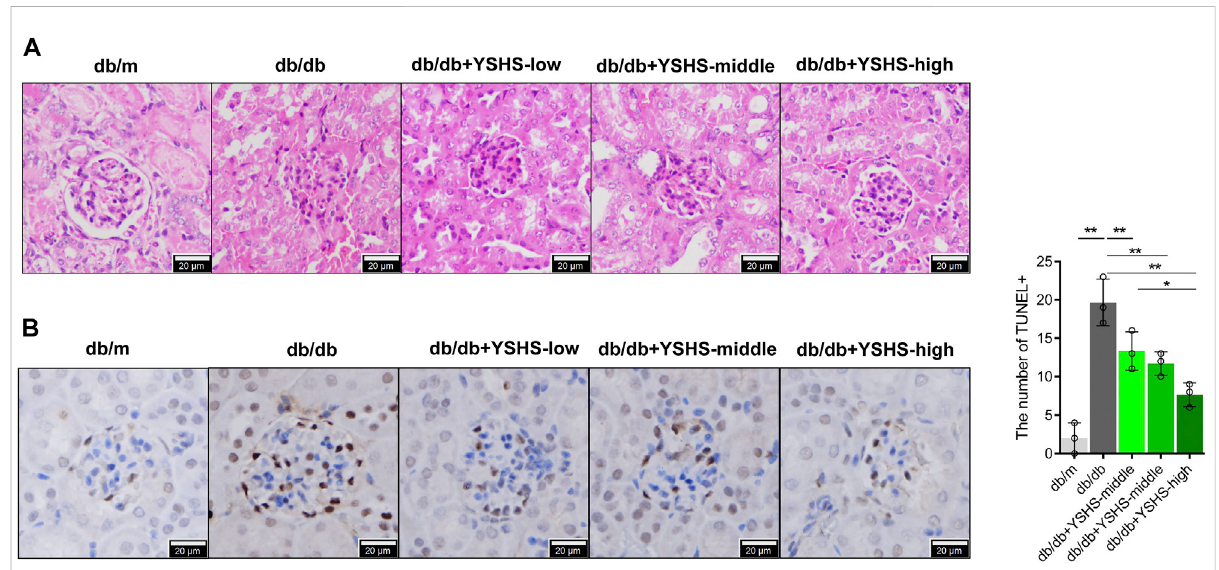
FIGURE 2 Effects of YSHS on glomerular structural lesions and glomerular cell apoptosis in db/db mice. (A) HE detected the glomerular structure of each group of mice. (B) TUNEL detected the glomerular apoptosis and statistical results of each group of mice. Data analysis adopts a one-way ANOVA analysis of variance, and error bars indicate SD.* p < 0.05 and ** p < 0.01. YSHS-low, YSHS-middle, and YSHS-high indicate the low-dose group, middle-dose group, and high-dose group of Yi-Shen-Hua-Shi granules drugs dose,